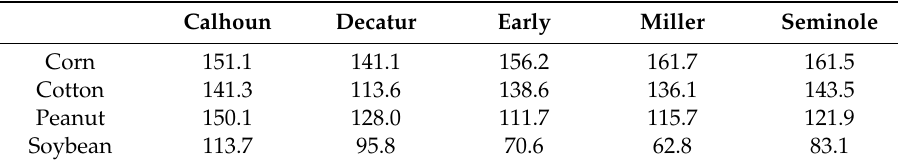
Table 2. 90th percentile of irrigation water applied (mm /